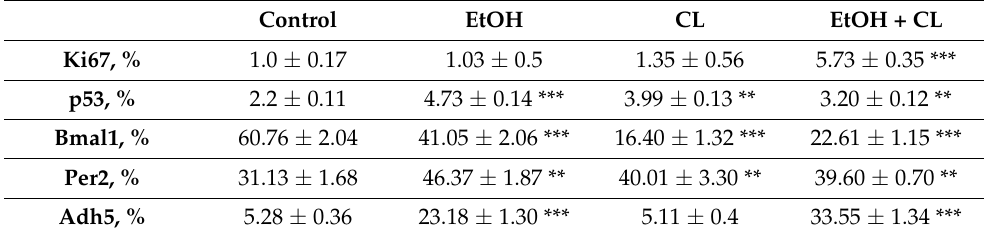
Table 4. Results of the immunohistochemical study on rat hepatocytes, * p < 0.05, ** p < 0.01, *** p <